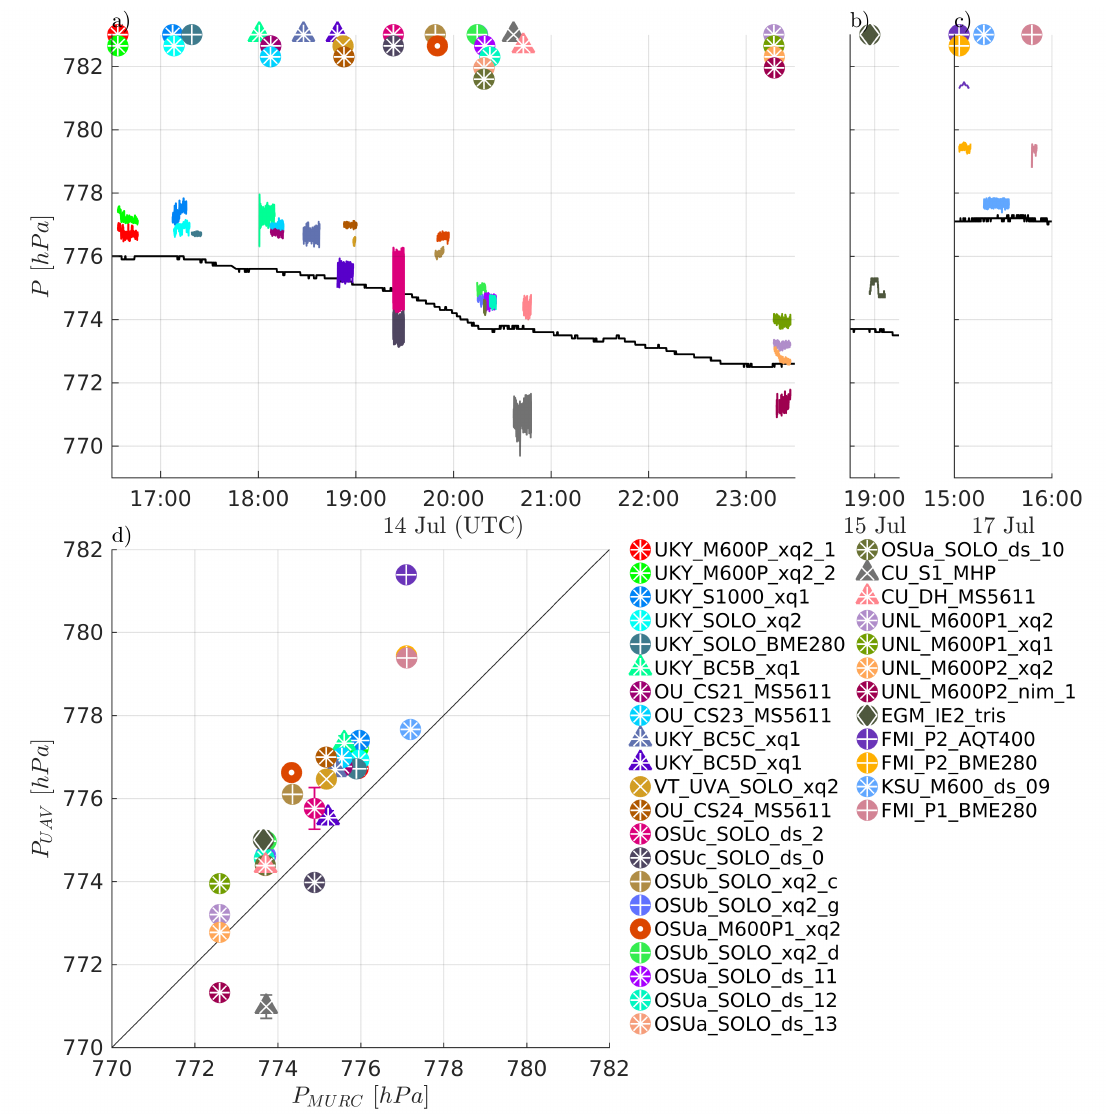
Figure 6. Time series of pressure measurements during July 14 ( a ), 15 ( b ), and 17 ( c ) and differences to MURC reference measurements ( d ). The colors and markers follow the same scheme as in Figure